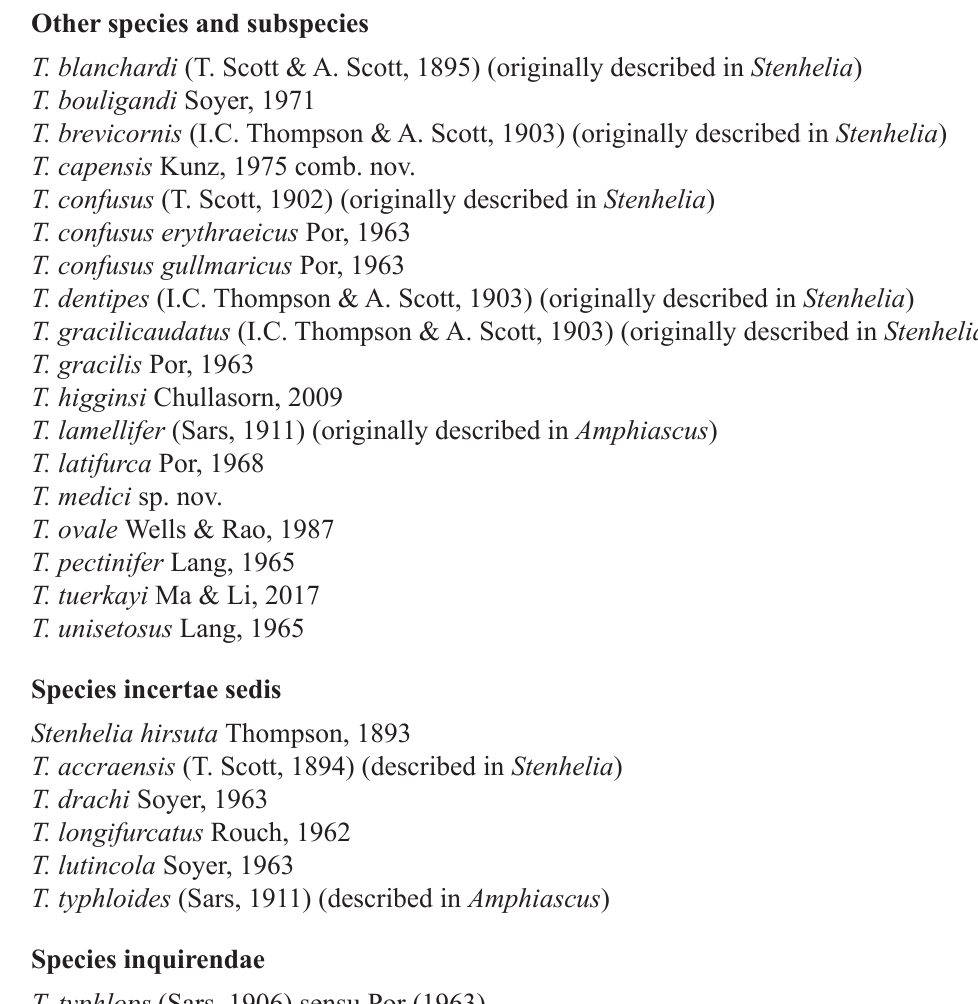
Miraciidae: Diosaccinae. Body fusiform; length : width ratio of caudal rami from about 1.0 to about 3.0. Rostrum not fused to cephalothorax, triangular, elongate, as long as first and second antennulary segments combined, with pointed tip, with one subdistal sensilla on each side. Female genital and third urosomites distinct dorsally and/or laterally, completely fused ventrally forming genital double-somite; genital and third urosomites separated in males. Length : width ratio of caudal rami variable, from 1 : 1 to 3 : 1. Female antennule seven- to nine-segmented, with aesthetasc and seta fused basally on fourth segment, and with apical acrothek on last segment. Male antennule haplocer, eight–ten-segmented, with aesthetasc and seta fused basally on fifth segment, and with apical acrothek on last segment. Antennulary setae typically smooth, except for few slightly setulose setae on penultimate and last articles in females and males. Antenna with allobasis; exopod three-segmented, armature formula 1-0-1,3,0. Mandibular